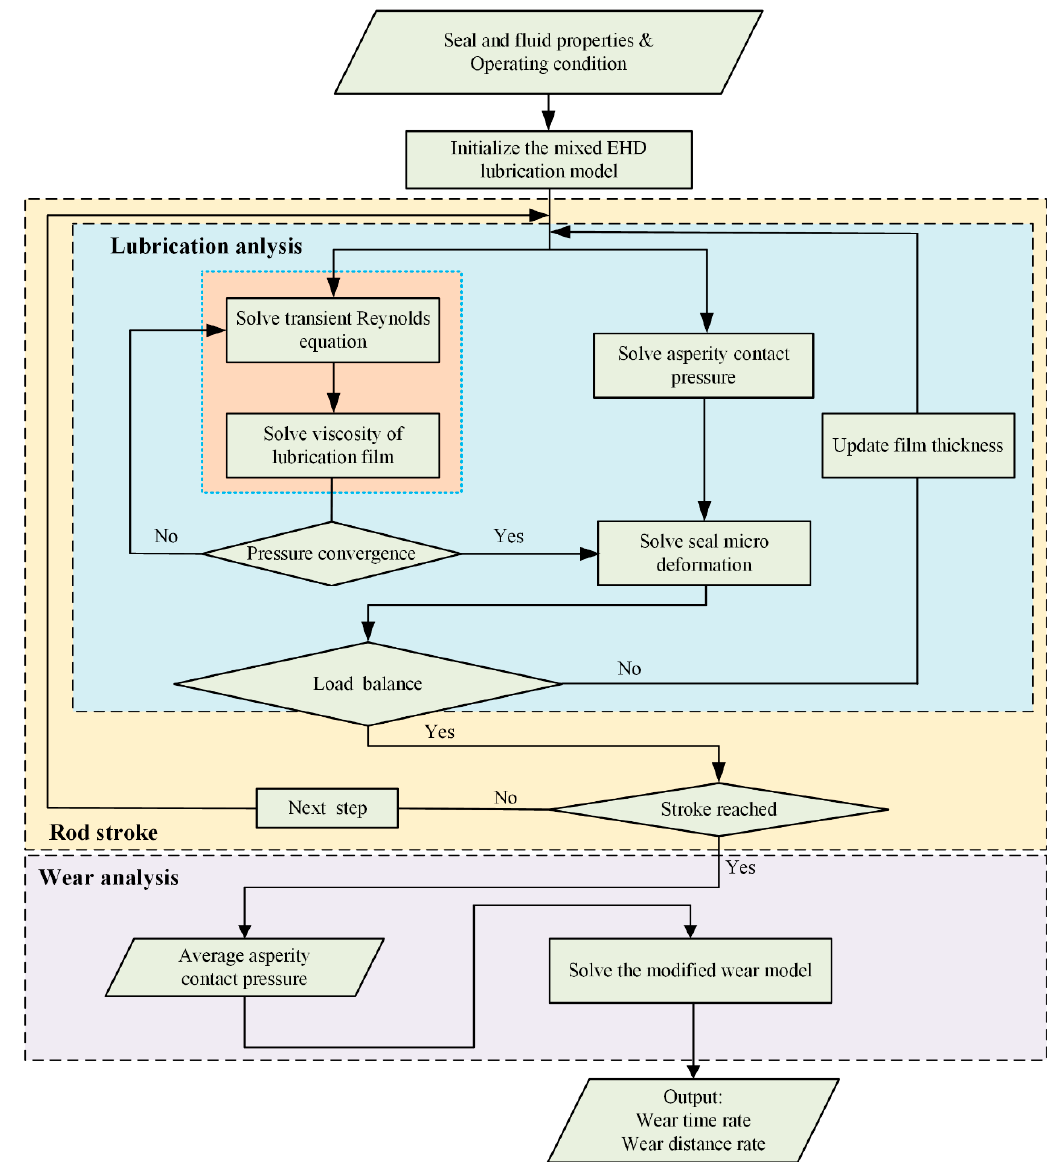
Figure 6. Scheme of computational